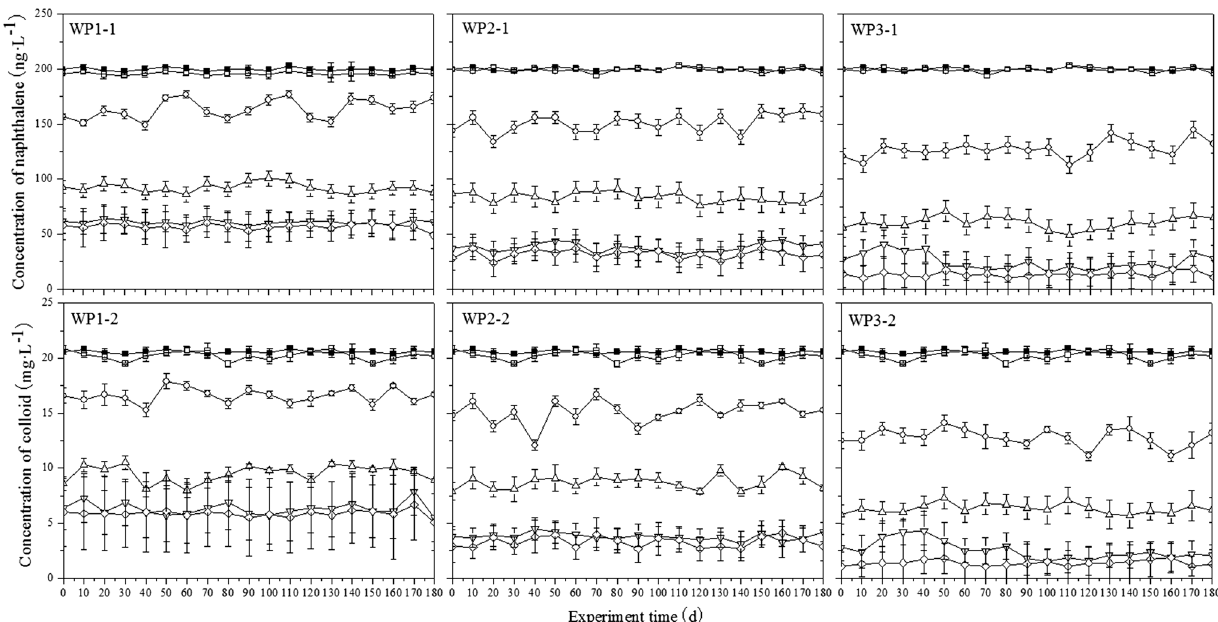
Fig. 2 Removal effects of the fillers on naphthalene by colloids in waters. Concentrations of naphthalene on humic acid colloids (WP1‑1), kaolin colloids (WP2‑1) and kaolin–humic acid com‑ pounded colloids (WP3‑1) in influents ( ) and the different effluents were gathered with the different filling percentages